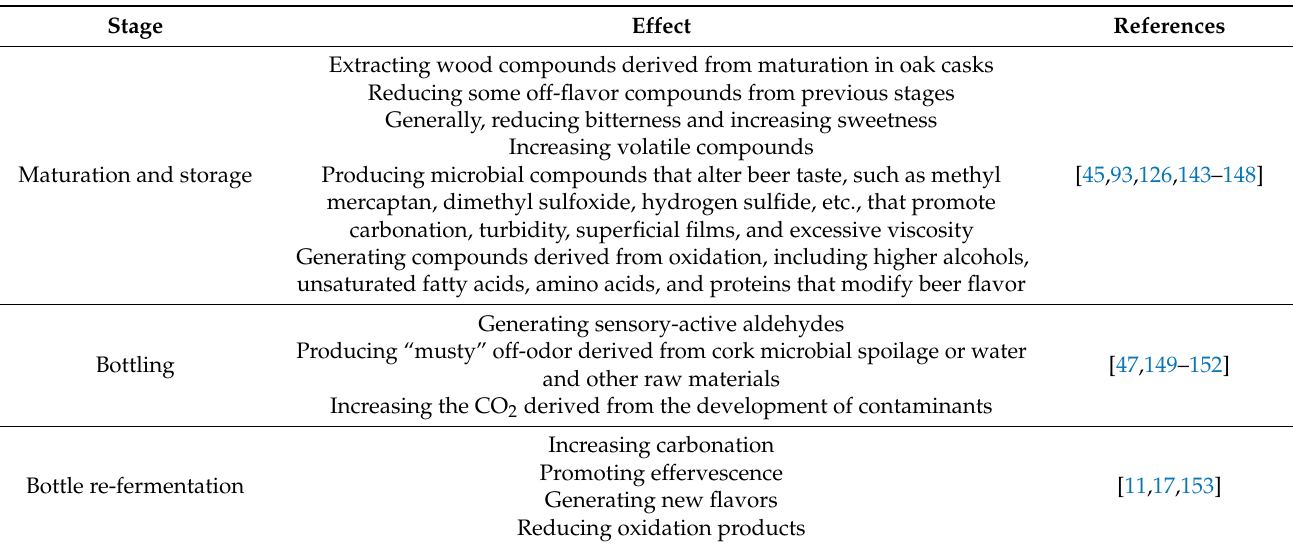
Table 3. Maturation, storage, and bottling effects that affect the sensory properties of